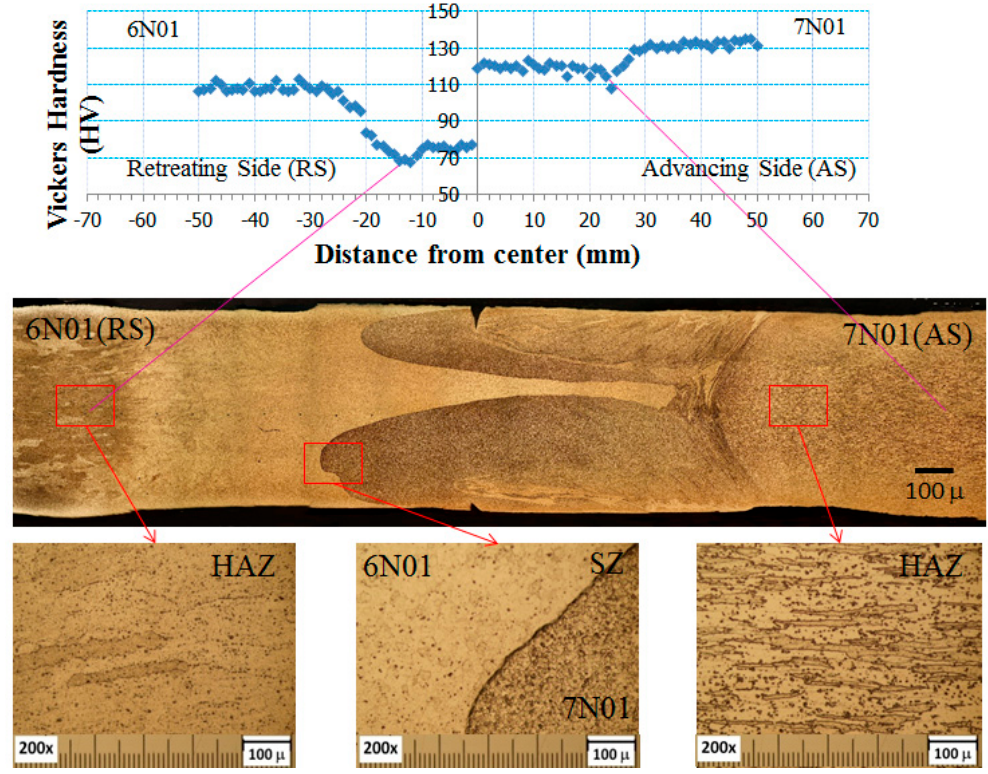
Figure 6. Microstructure and hardness distribution for the 6N01-7N01 FSW.